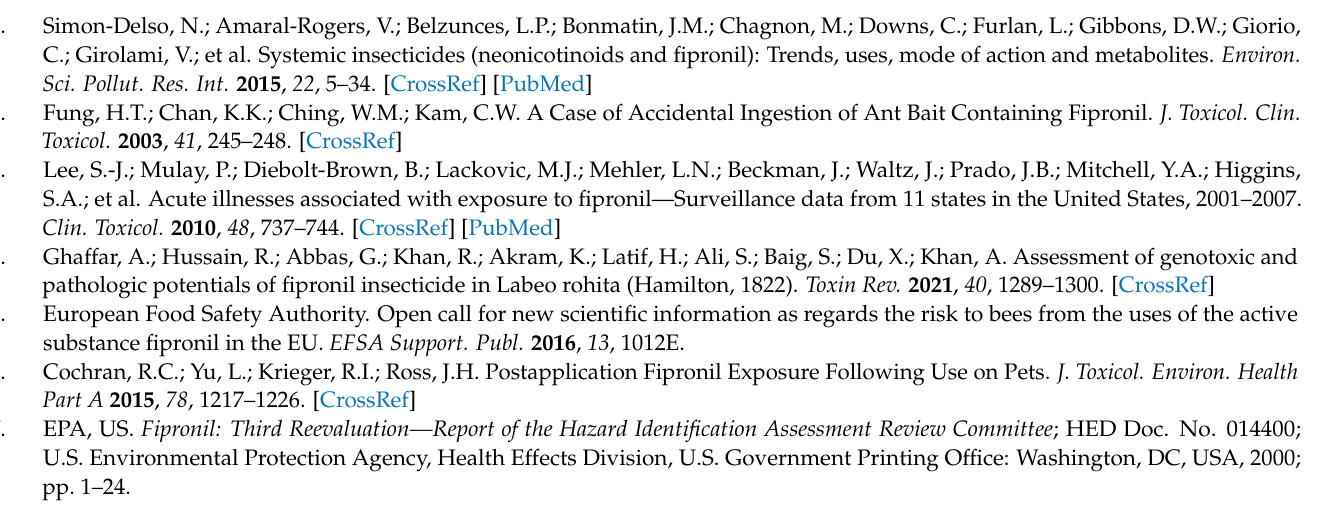
sequencing; Figure S2: Gold nanoparticle synthesis and characterization: (a) A TEM image showing spherical morphology and physical diameter of AuNPs, (b) size distribution graph of fabricated AuNPs, and (c) a magnified view clearly revealing the lattice structure of